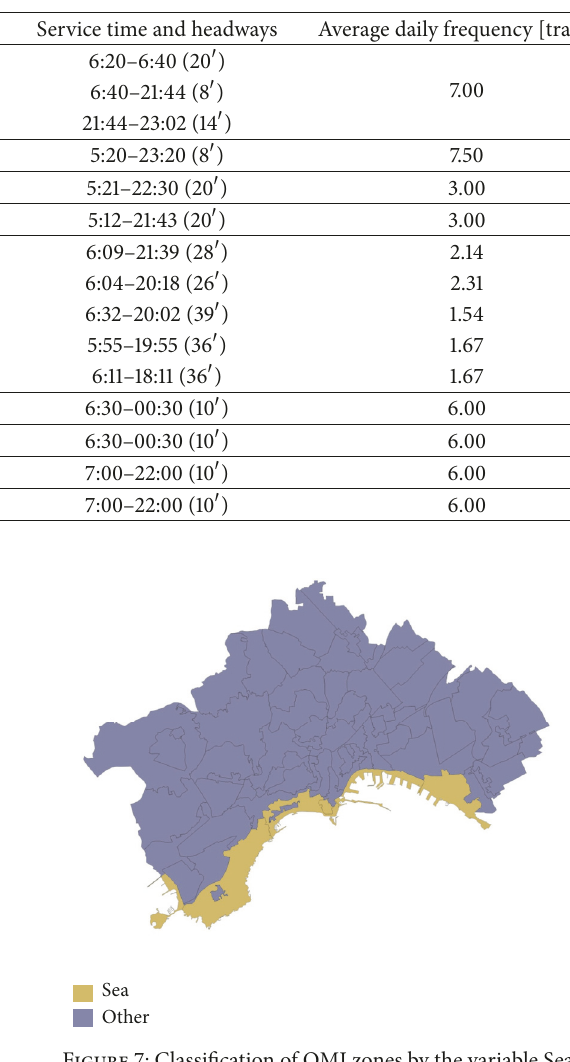
Figure 7: Classification of OMI zones by the variable